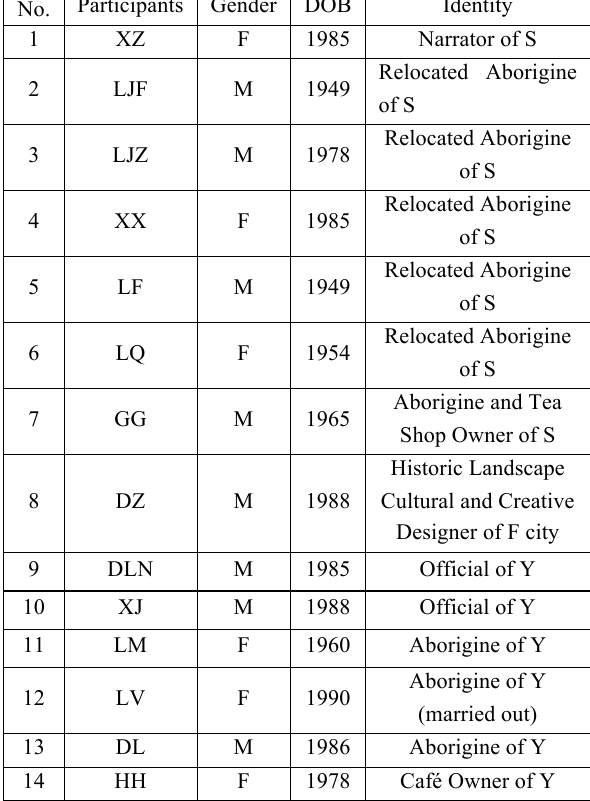
Table 1 . Information of participants (Anonymized).